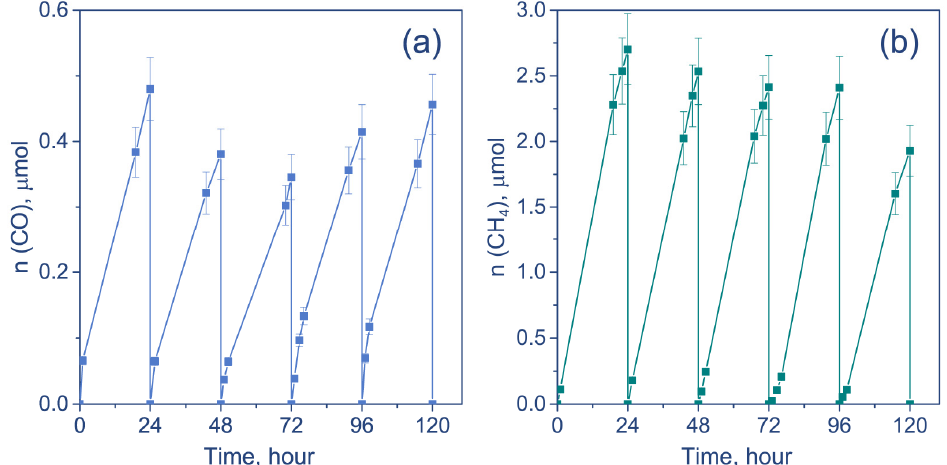
Figure 7. The amounts of ( a ) CO and ( b ) CH 4 formed during the stability test. Conditions: m(cat.) = 30 mg, P 0 (CO 2 ) = 1 atm, t (1 run) = 24 h, λ = 400 nm.